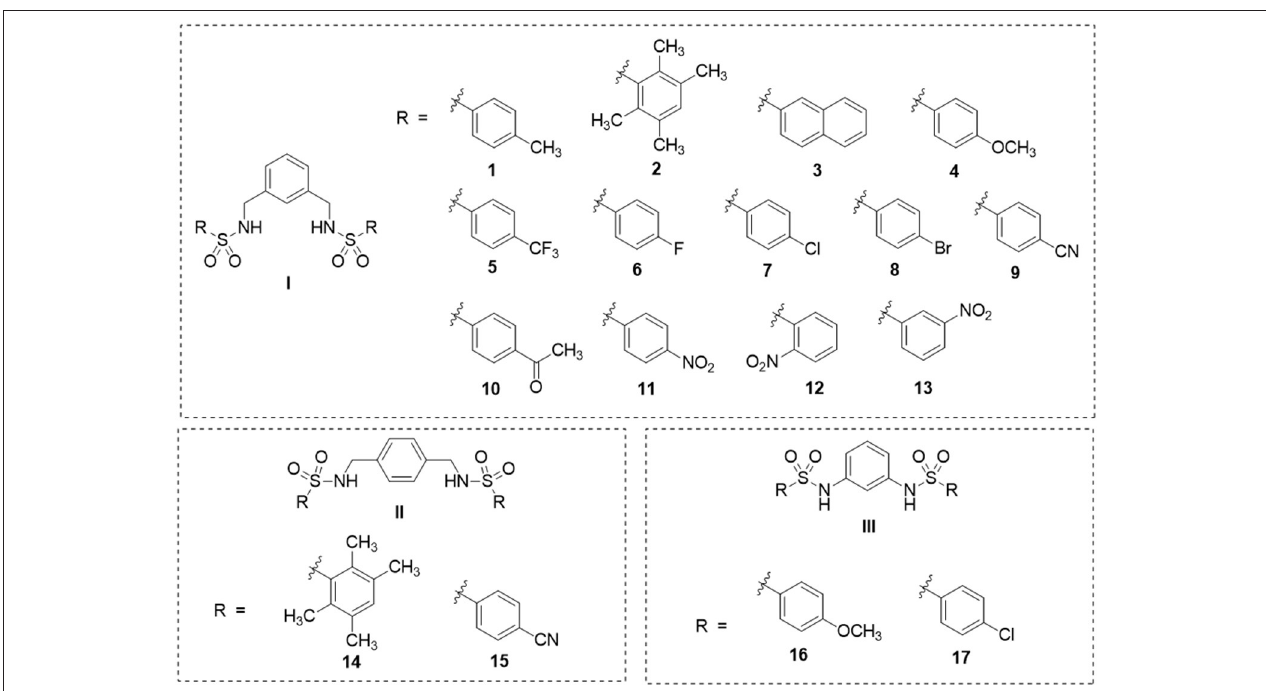
FIGURE 1 | Chemical structures of in-house bis-sulfonamides ( 1 – 17